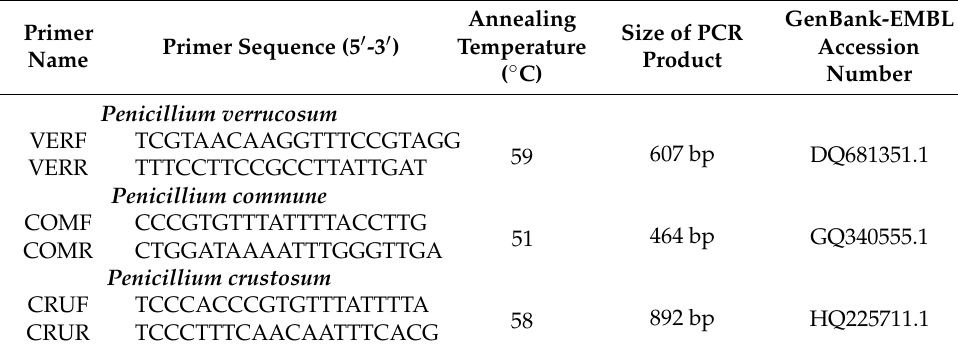
Table 1. Primers designed and used in this study.